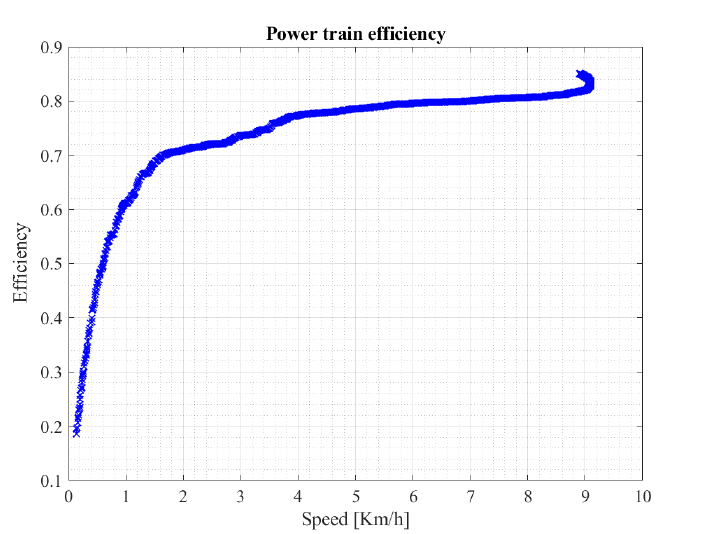
Figure 14. Profile of speed, torque, and power acquired during experimental